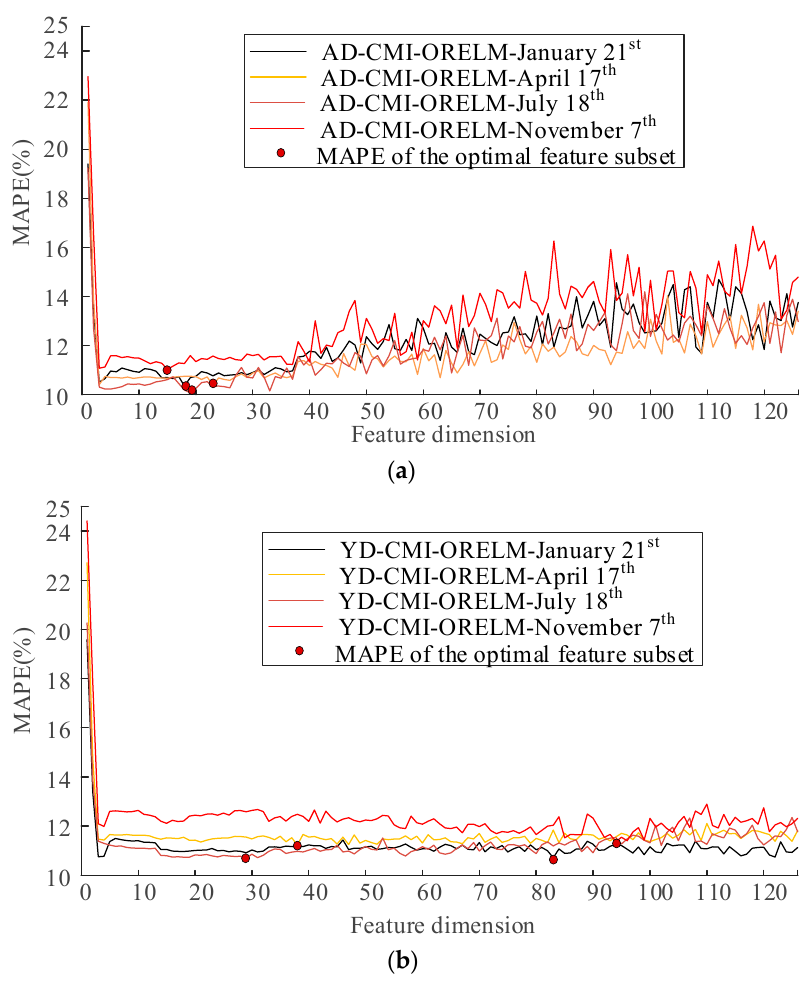
Figure 6. Optimal feature selection curves. ( a ) Analysis curves with AD data; ( b ) Analysis curves with YD data.